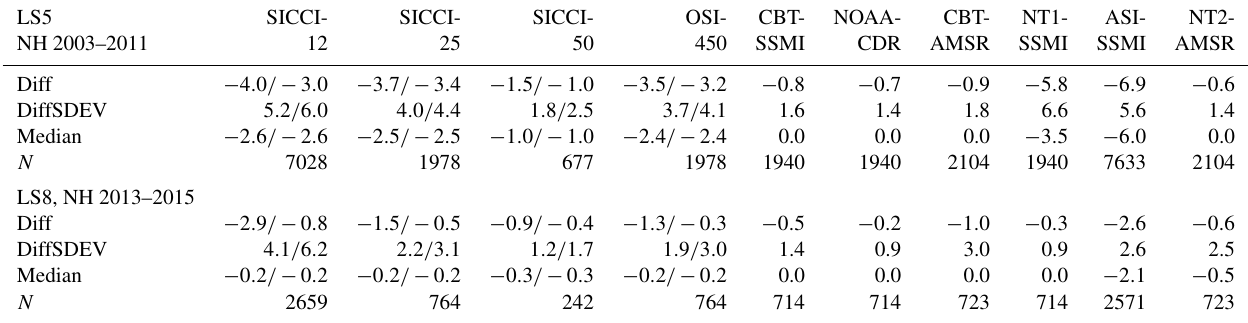
Table 10. Summary of statistical results obtained in the Northern Hemisphere for 28 cases with first-year ice (top, LS5, NH 2003–2011) and for 12 cases with mixed first-year–multiyear or multiyear ice (bottom, LS8, NH 2013–2015). See Table 5 for an explanation of the parameters shown. For SICCI-2 and OSI-450 products, we include in all rows but “ N ” values based on non-truncated (near 100%) SIC data to the right of the “/”. We omit slope and intercept because SIC data pairs cluster at